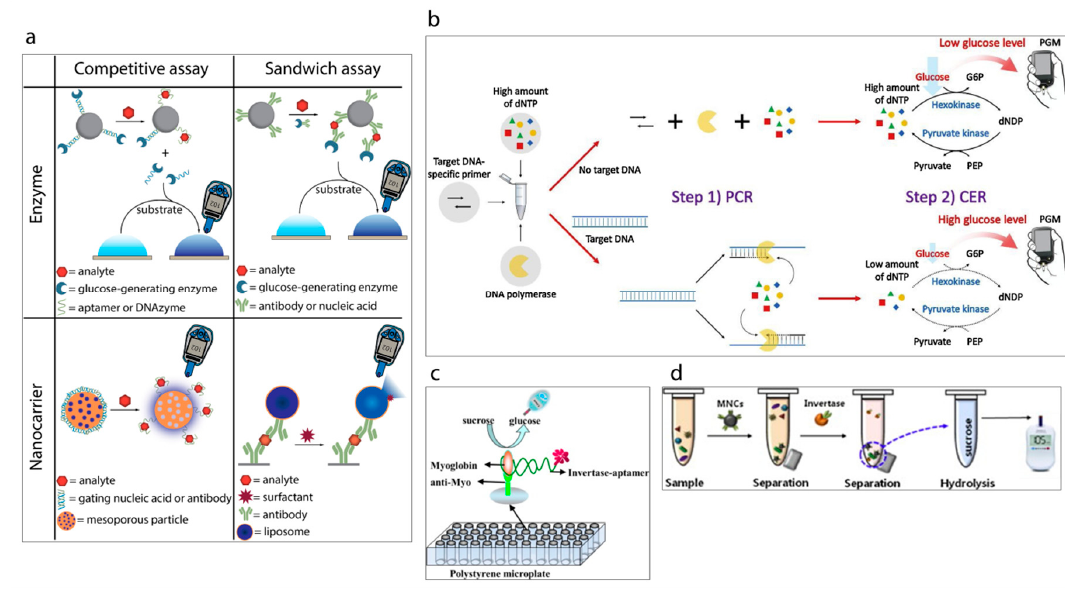
Figure 9. ( a ) Classification of the strategies to detect analytes other than glucose using a personal glucose meter [119]. ( b ) Schematic illustration of PGM-based label-free strategy for target DNA detection [123]. ( c ) Schematic illustration of myoglobin detection using aptamer and personal glucose meter [133]. ( d ) A schematic illustration of the experimental procedure using a personal glucose meter for the detection of Salmonella bacteria [129].